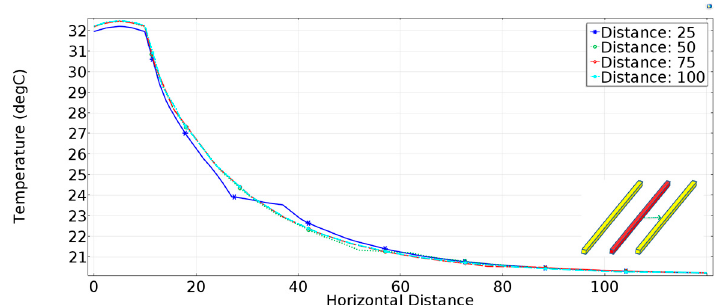
Figure 3. The lateral temperature distribution of the structure shown in the insert in case the under-etched cavity is filled with air, and the biofuel is pure ethanol (distances in μ m).